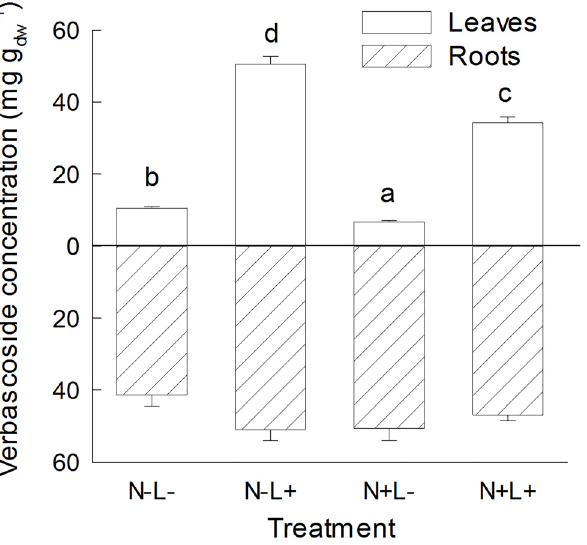
Fig 2. Verbascoside concentrations in leaves and roots of Plantago lanceolata . Plants were grown at different light and nutrient availability (N-: low nutrient, N+: high nutrient, L-: low light, L+: high light). Values are means across all plants per treatment (+ 1 SE). Results of Tukey`s test applied to test for significant differences between different light x nutrient treatments are indicated with letters.